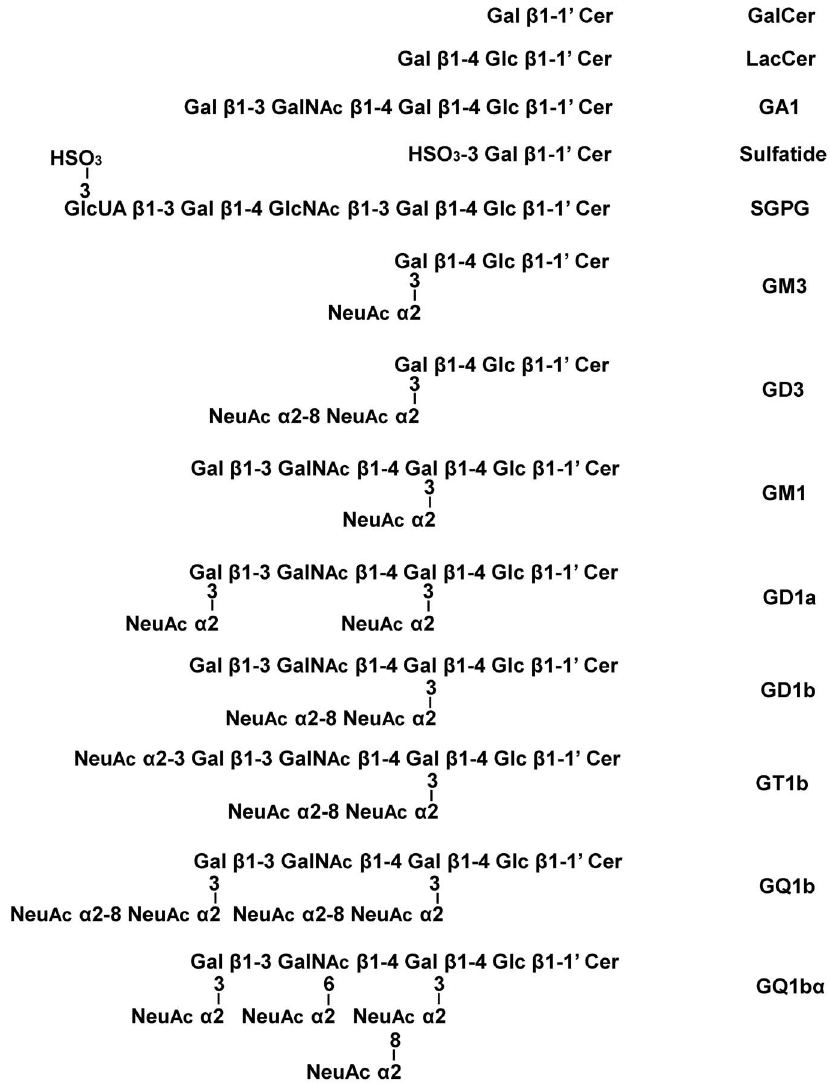
Figure 1. Structures of glycosphingolipids cited in this study. Symbols used for gangliosides and other glycosphingolipids are based on the system of Svennerholm and the nomenclature recommended by IUPAC.